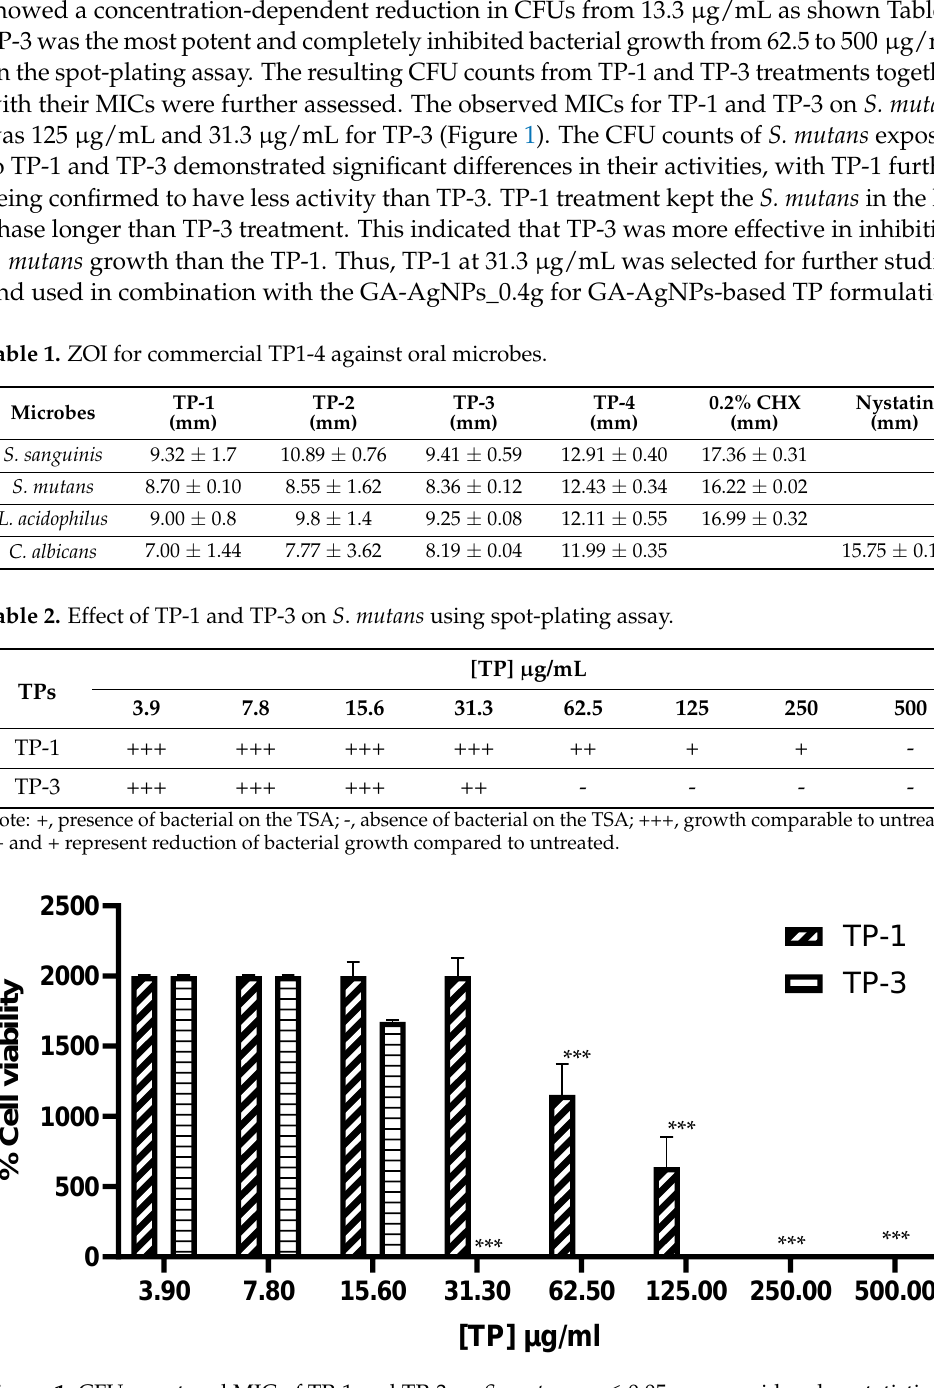
Table 1. ZOI for commercial TP1-4 against oral microbes.